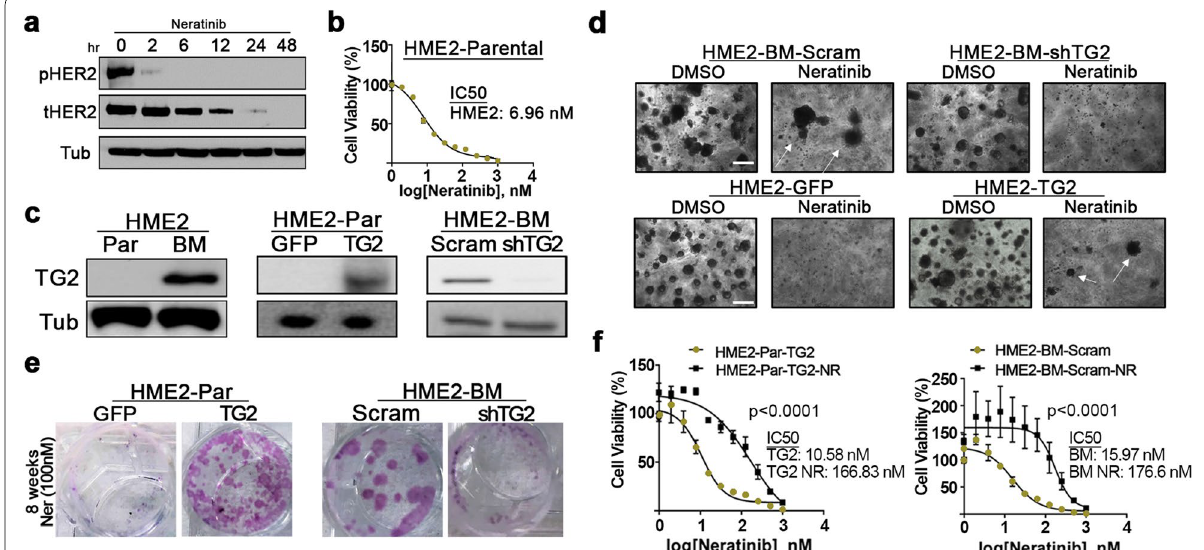
Fig. 1 Transglutaminase 2 facilitates neratinib resistance. a HME2-partenal cells were treated with neratinib (1 µM) for the indicated amounts of time and phosphorylated (p) and total (t) HER2 were evaluated by immunoblot. β-tubulin was used as a loading control. b HME2-parental cells were treated (96 h) with neratinib at the indicated concentrations and cell viability was assayed. Data are the mean SE of three independent ± experiments resulting in the indicated IC50 value. c Immunoblot analyses for TG2 in HME2 parental (Par) and bone metastases (BM). HME2-GFP, HME2-TG2, HME2-BM-scram and HME2-BM-shTG2 were also assessed for TG2 expression. β-tubulin was used as a loading control. Data are representative of at least three independent experiments. d TG2 manipulated cells were seeded under single-cell 3D culture conditions in the presence of DMSO or neratinib (100 nM). Images of each condition at day 27 are shown. e TG2 manipulated cells were treated in 2D culture every three days with neratinib (100 nM) for a period of 8 weeks. Crystal violet was used to stain representative wells with at the indicated time points to visualize drug resistant cells. f The neratinib resistant (NR) cells were cultured for an additional 4 weeks without neratinib. The drug resistant cells and passage matched HME2-BM-Scram and HME2-Par-TG2 cells were treated with the indicated concentrations of neratinib for 96 h and cell viability was assayed. Data are the mean of three independent